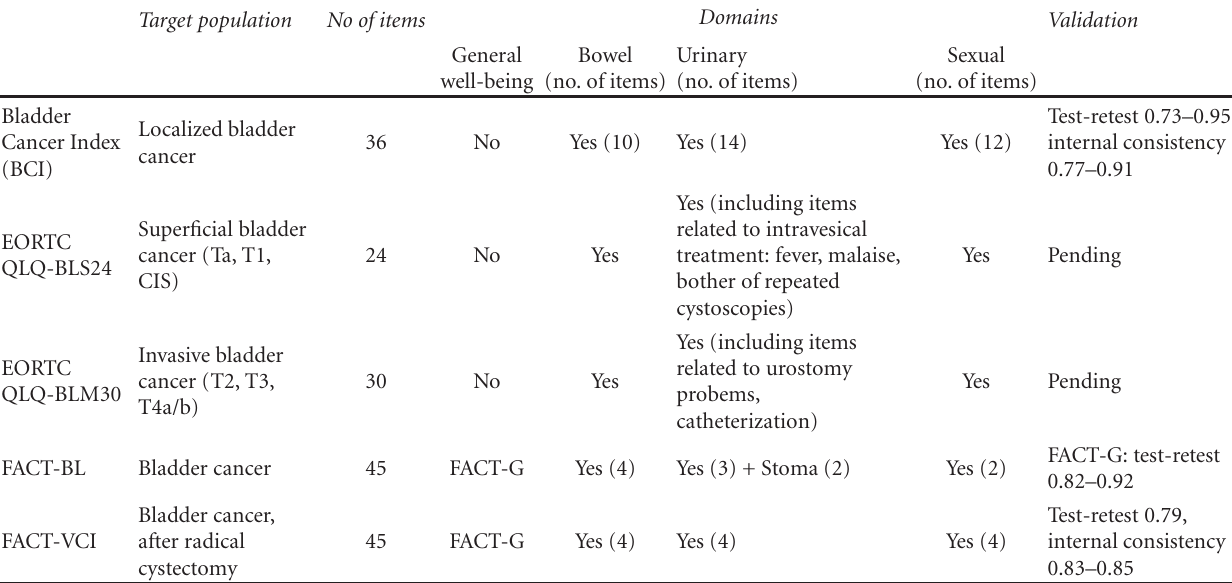
Table 1: Comparison of bladder cancer specific HRQOL